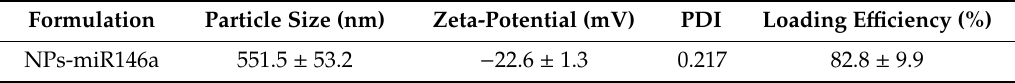
Figure 1. ( A ) Characterization by transmission electron microscopy. ( B ) miR-146a cumulative release curves from the nanoparticles. The fluorescence intensities of each sample collected at each time point were measured, and the fluorescence from the blank control was subtracted. The cumulative release curve was calculated based on the obtained concentration. ( C ) The formulation at room temperature (a, gel/NPs/miR-146a) and at 34 °C (b, gel/miR-146a; c, gel/NPs/miR-146a). The data are expressed as the mean ± SD, n = 4. Table 1. Physicochemical characteristics of the